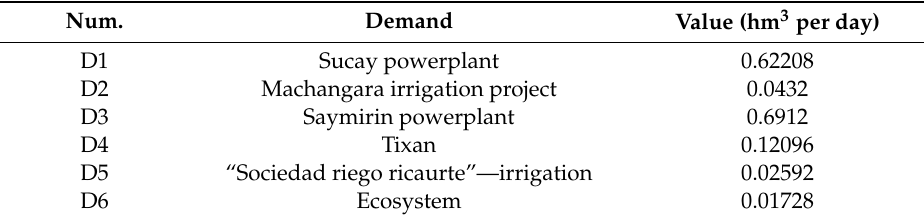
Table 1. Daily water demand of the demand nodes